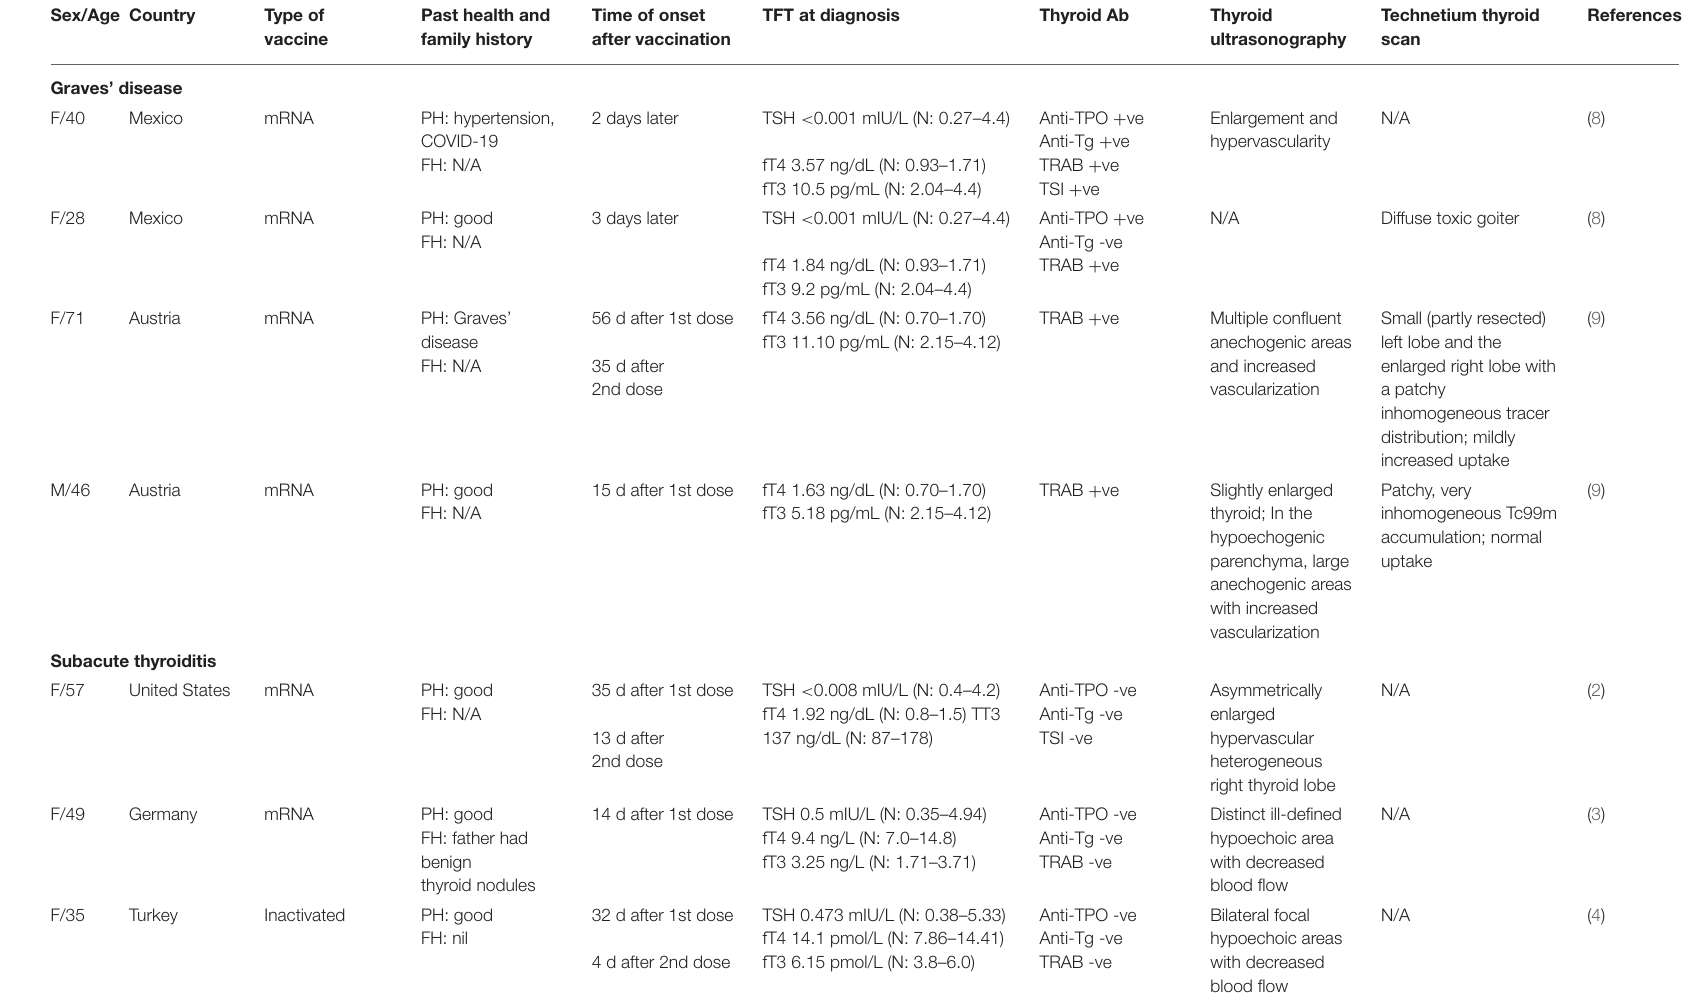
TABLE 2 | Case reports of thyroid dysfunction after SARS-CoV-2